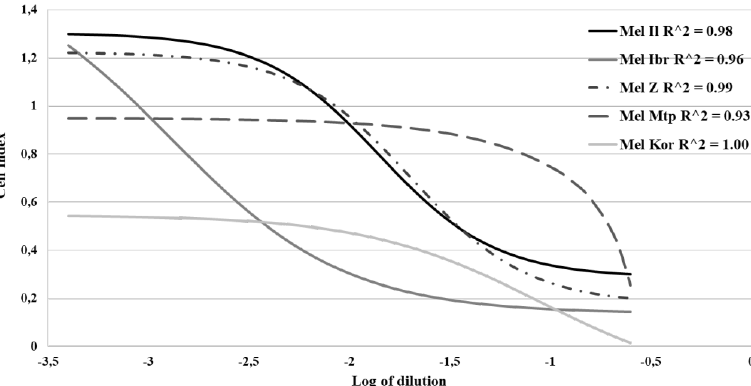
Figure 3. Sigmoidal dose-response for MV-infected melanoma cell lines. The sigmoidal dose-response curves were plotted and ED 50 dilutions of MV were interpolated using the xCELLigence software for each cell line by the formulae—Y = Bottom + (Top - Bottom)/(1 + 10^(Log EC 50 − X)). The X axis represents Log of dilution of MV, the Y—Cell Index reflected the number of viable cells.